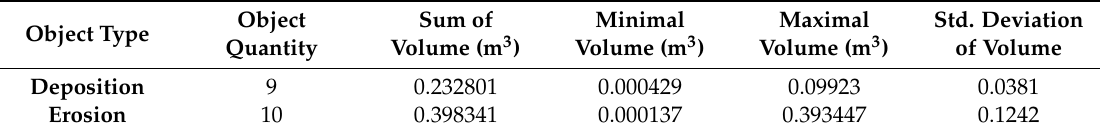
Table 3. Volume Statistics of Erosional and Depositional Objects.